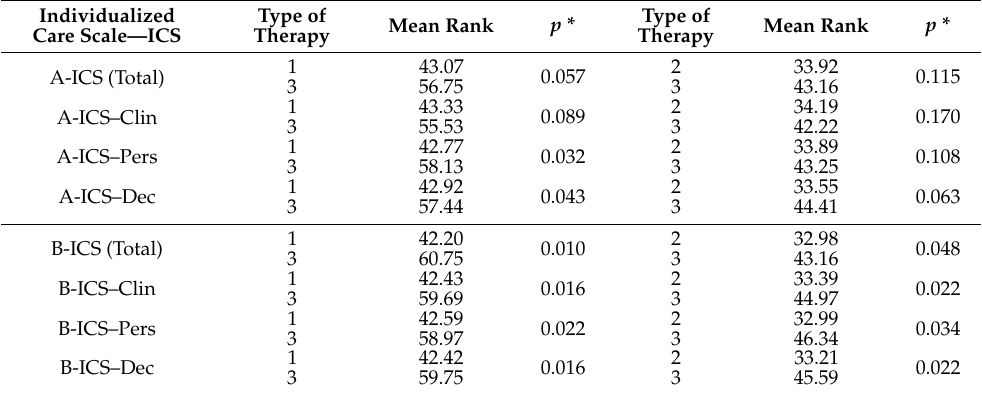
Table 6. Patients’ assessments of individualized care at the ICS dimension and sub-scale levels in relation to the current type of glucose-lowering